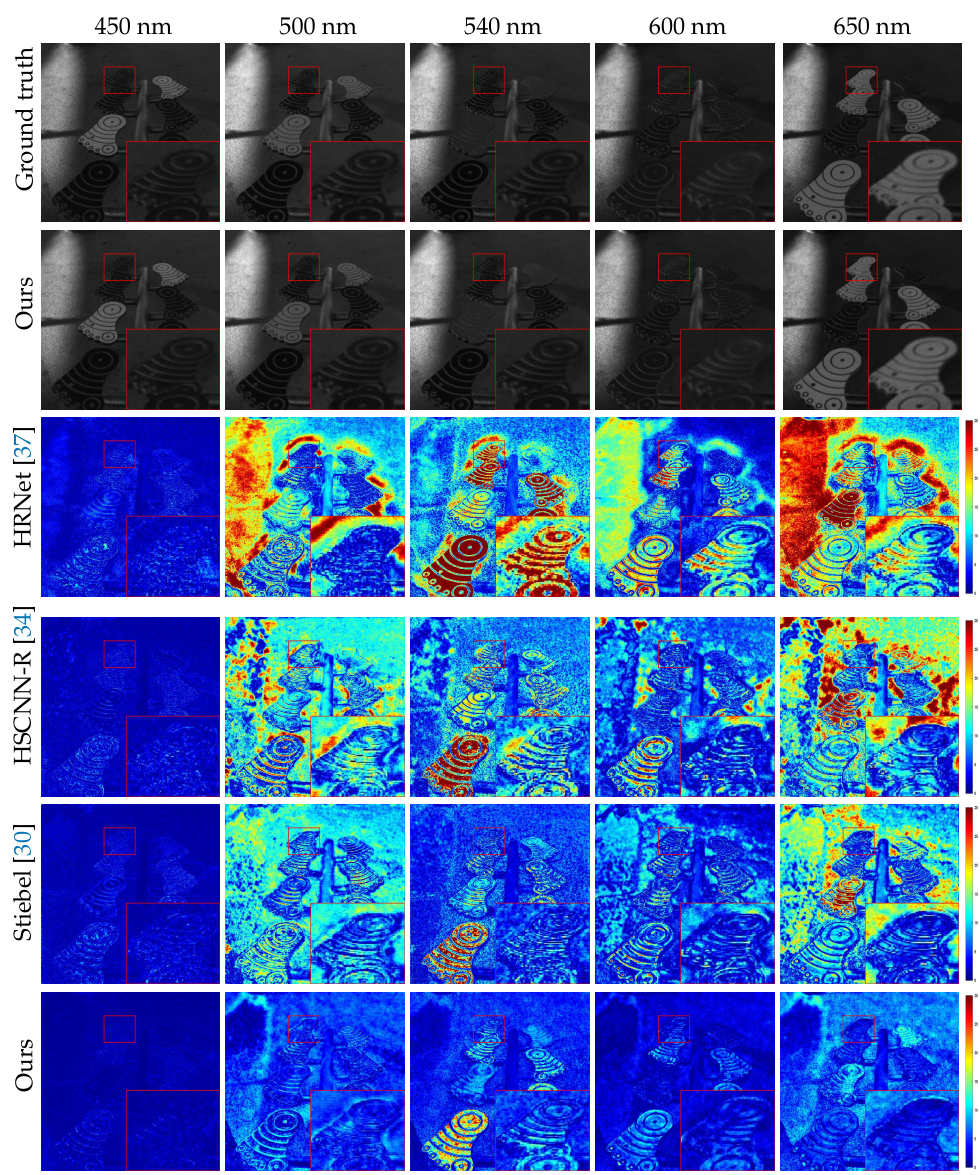
Figure 5. Visual comparison of the five selected bands on “ARAD_HS_0455” image from the final testing set of NTIRE2020 “Clean” track. The best view on the